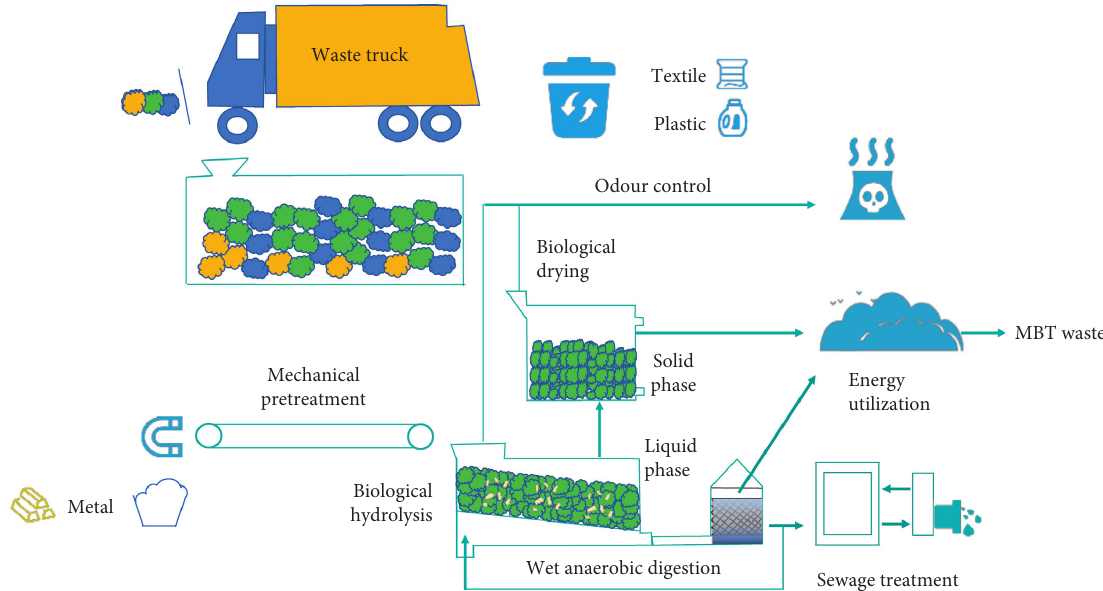
Figure 1: Mechanical biological treatment (MBT)